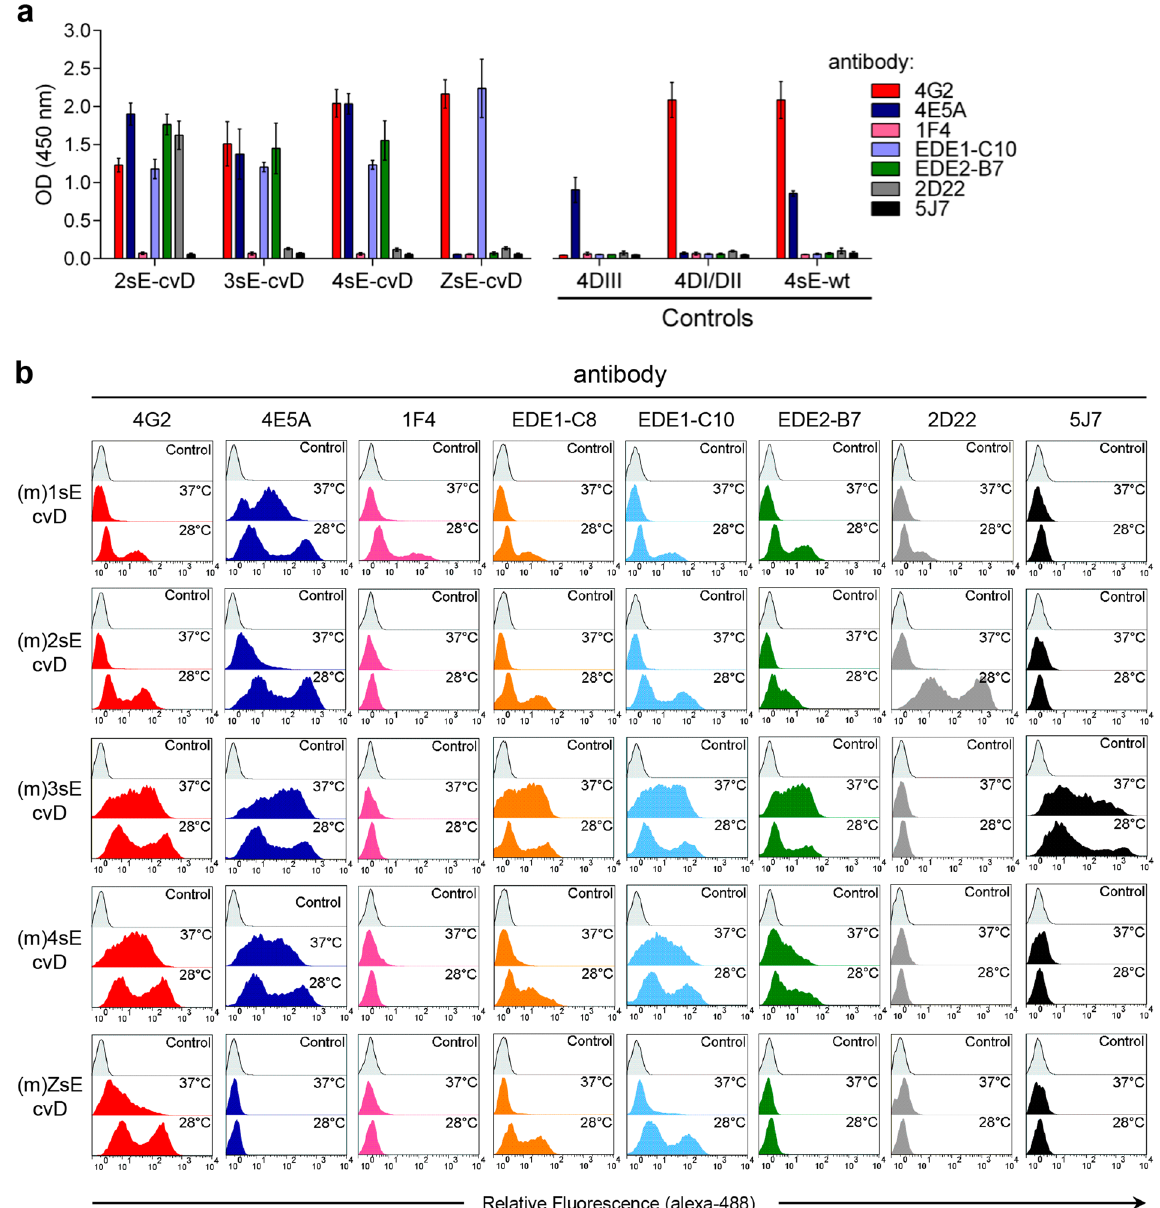
Figure 2. Structural analysis of covalently stabilized E dimers. ( a ) ELISA of sE-cvD from DENV serotypes 2, 3 and 4 and ZIKV with the indicated mAbs (left panel), data is represented as mean ± s.d. (for all mAbs, n = 5). Control antigens, 4DIII, 4DI/DII and 4sE wt were also reacted with the same set of antibodies (right panel), data is represented as mean ± s.d. (for all mAbs, n = 5). ( b ) Cytofluorimetric analysis of HEK-293T cells transfected with the membrane display sE-cvD versions of all four DENV serotypes and ZIKV at 37 °C or 28 °C and reacted with the indicated mAbs. Mock-transfected HEK-293T cells incubated with each mAb served as